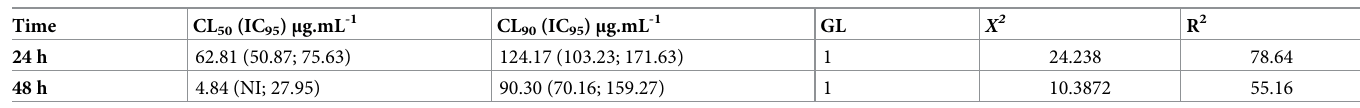
Table 3. Insecticide response-concentration on larvae of A . aegypti